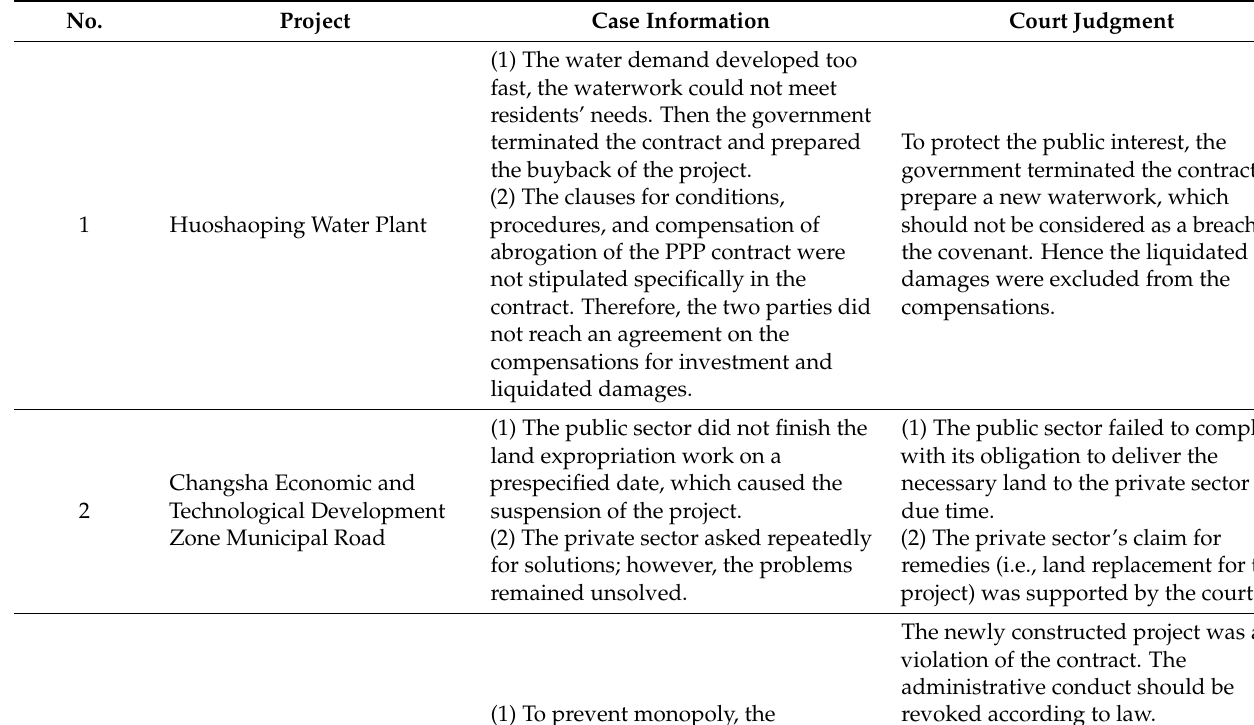
Table 1. Process used to identify causes for PPP